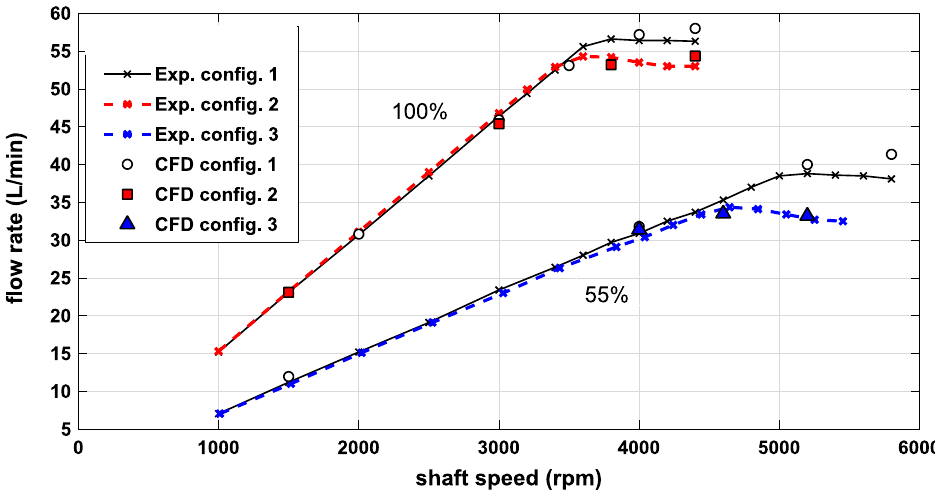
Figure 6. Flow-speed characteristics at 0.2 MPa and at two fixed displacements (blocked): maximum (100%) and partial (55%).